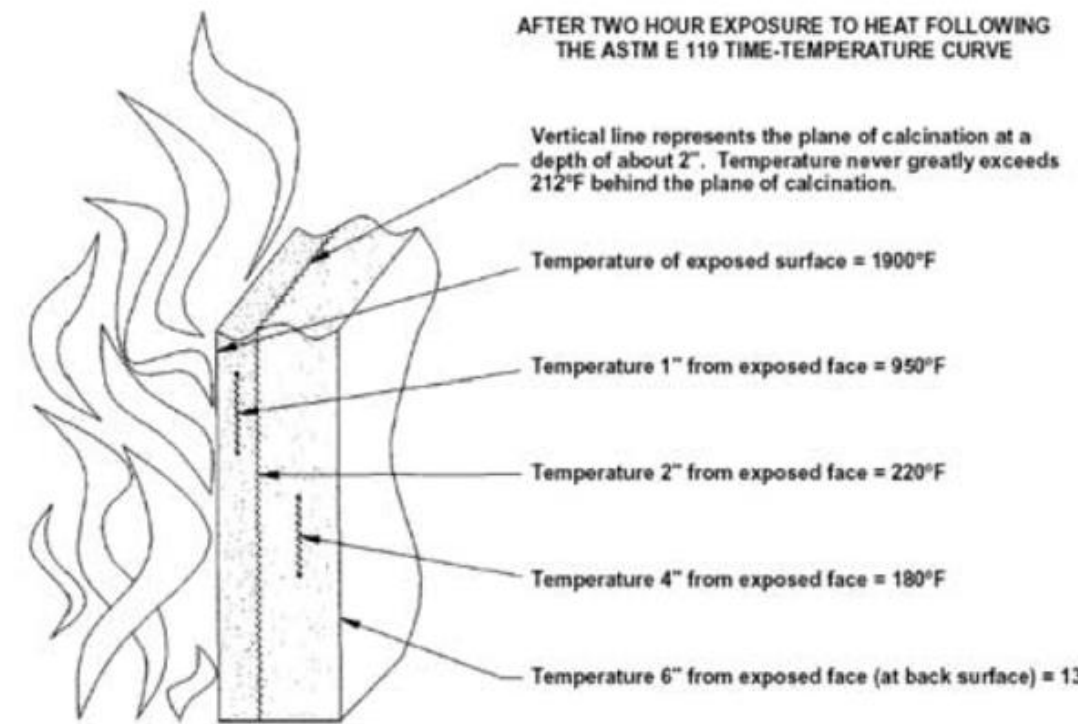
Figure 10. Fire guard characteristics of Type X gypsum board